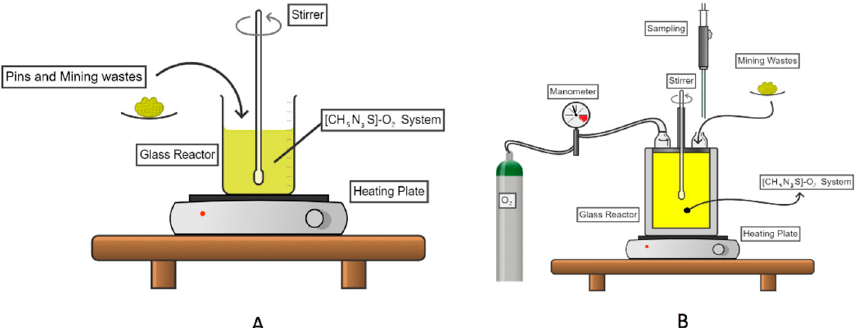
Figure 2. Schematic image of the experimental apparatus used for; ( A ) The leaching of WEEE and MW at open atmospheric conditions, and ( B ) For the study of the effect of O 2 partial pressure during MW leaching.